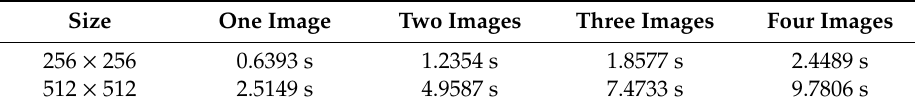
Table 4. The time of encrypting di ff erent numbers of